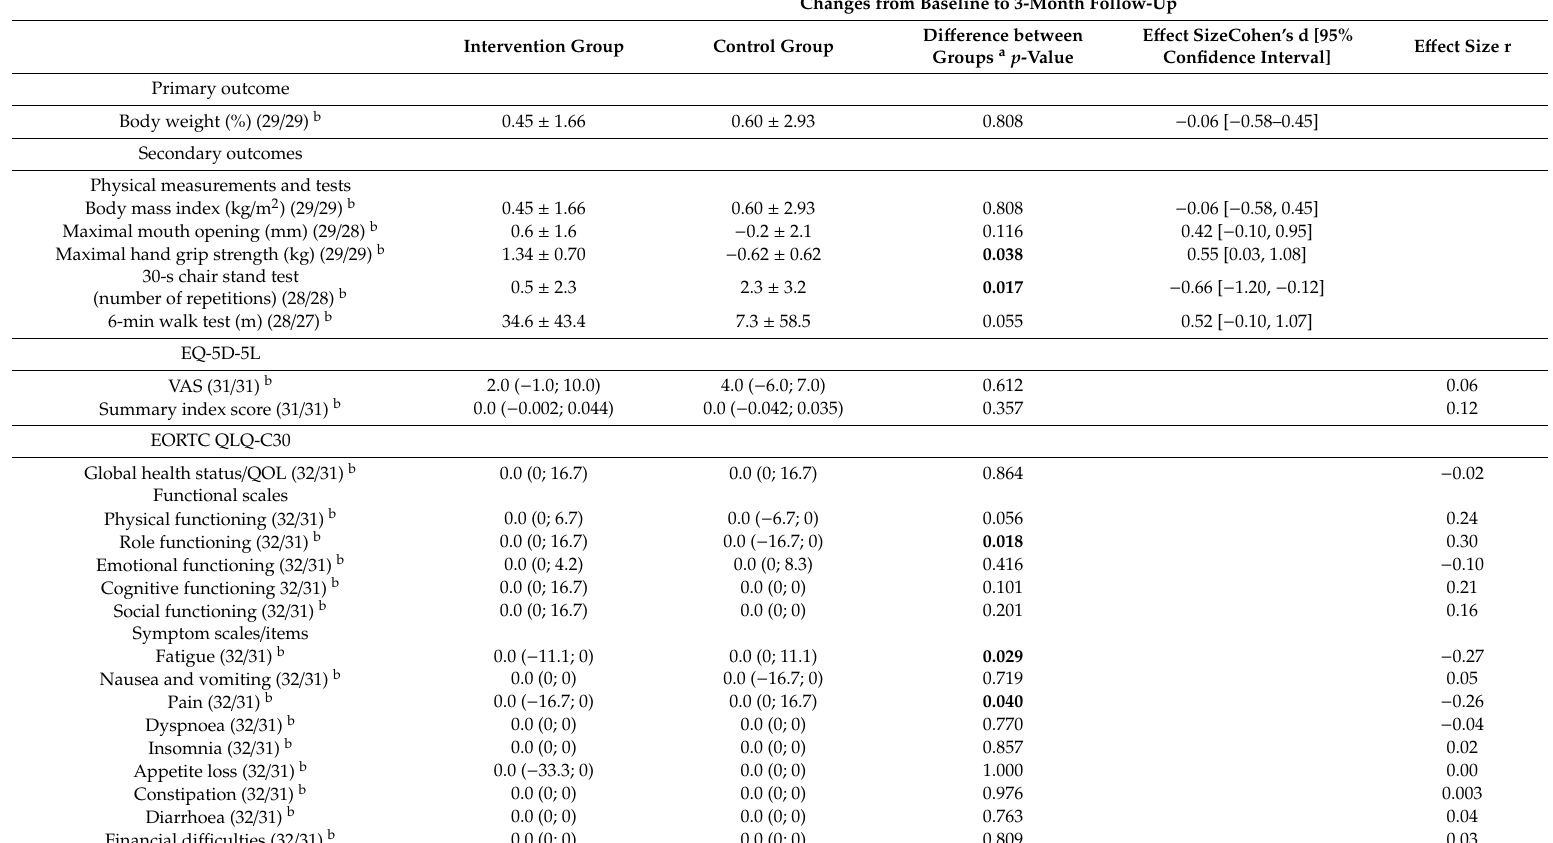
Table A3. Sensitivity analyses of di ff erences between intervention and control group excluding participants with cancer relapse between baseline and 3-month follow